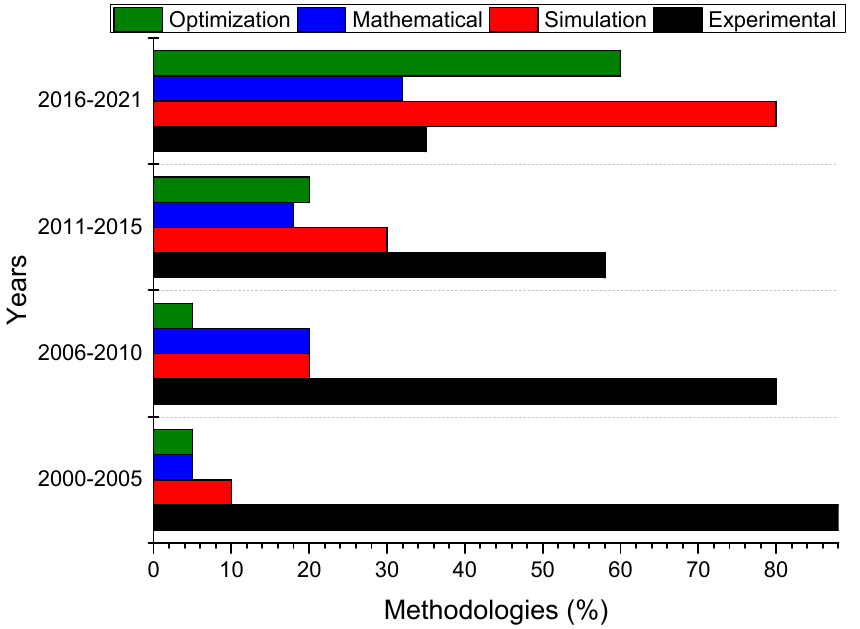
Figure 14. Trends in research methodologies in active control of flow.